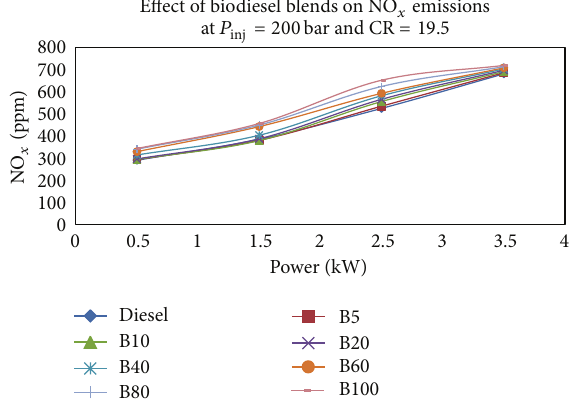
Figure 18: Variation in NO 𝑥 for various biodiesel blends at 𝑃 200 bar and CR 19.5.